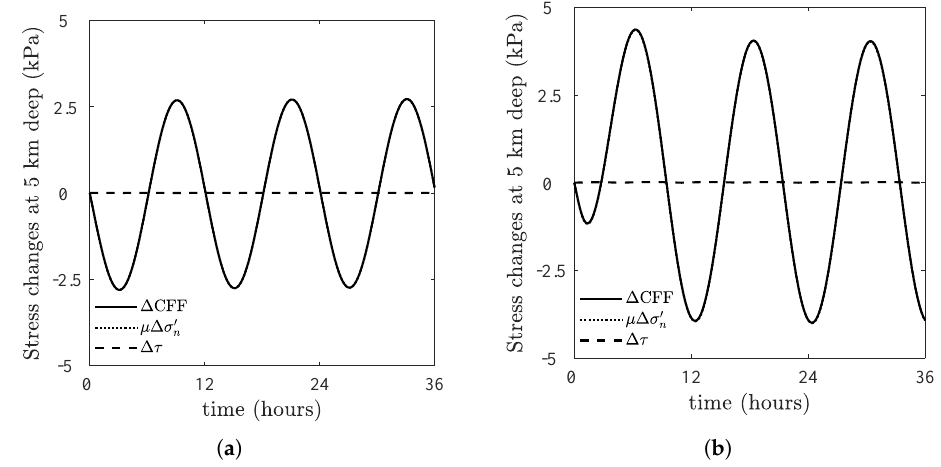
Figure 7. Time evolution of Coulomb Failure Function for two tidal cases at 5 km depth. Here we represent the CFF changes, as well as the resistance and the shear stress changes. As the latter are almost negligible, ∆ CFF and resistance changes are quite similar. Positive values indicate increase in likelihood of failure, while negative values favor fault stability. A higher value of the fault permeability attenuates the ∆ CFF changes and increases the phase lag. On panels ( a ) and ( b ), the intrinsic fault permeability is k F = 10 − 11 and 10 − 9 m 2 , respectively, and the rock intrinsic permeability is 10 − 15 m 2 . Table 2 lists the parameters of the simulations. The Young modulus of the rock and fault are, respectively, 40 and 1 GPa, and the Biot coefficient, α B , is 0.8, ( a ) k F = 10 − 11 m 2 , ( b ) k F = 10 − 9 m 2